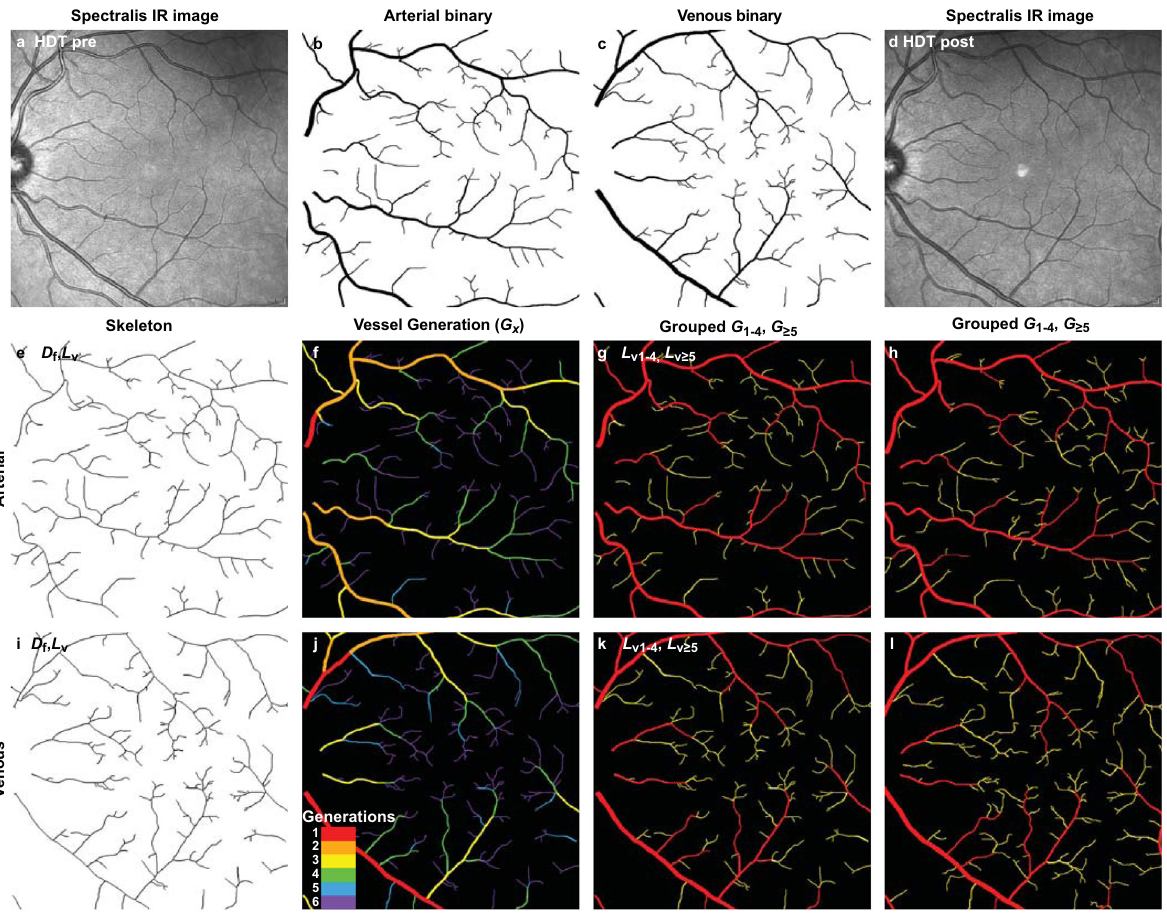
Fig. 2 Mapping and quanti fi cation by VESGEN of retinal vascular patterning before and after HDT. a From the grayscale Spectralis IR image of the right retina of subject 2 acquired before 70 days of HDT (Supplementary Table 2), binary images of the b arterial and c venous trees were extracted to serve as the sole image inputs to VESGEN. d The same procedure was followed for the image acquired after 70 days of HDT. e , i The skeleton (centerline) of the pre-HDT arterial or venous tree was calculated by VESGEN that, together with the input binary image, generated additional maps of arterial and venous branching generations ( f , j , legend). These generational maps were further grouped by the software into large ( L v1-4 , red) and small ( L v ≥ 5 , yellow) vessels ( g , k ) for calculation of the fi nal grouped vascular results (Table 2, Supplementary Table 2) 18,24 . The same analysis was followed for the post-HDT image ( d , illustrated in h and l ). Scale bars ( a , d ), 200 μ (Figs. 2 – 3; Supplementary Table 2). Overall arterial and venous length densities ( L v ) in Fig. 2, for example, were quanti fi ed as 14.88 × 10 – 4 μ m/ μ m 2 and 14.10 × 10 – 4 μ m/ μ m 2 before HDT, compared to 15.91 ×